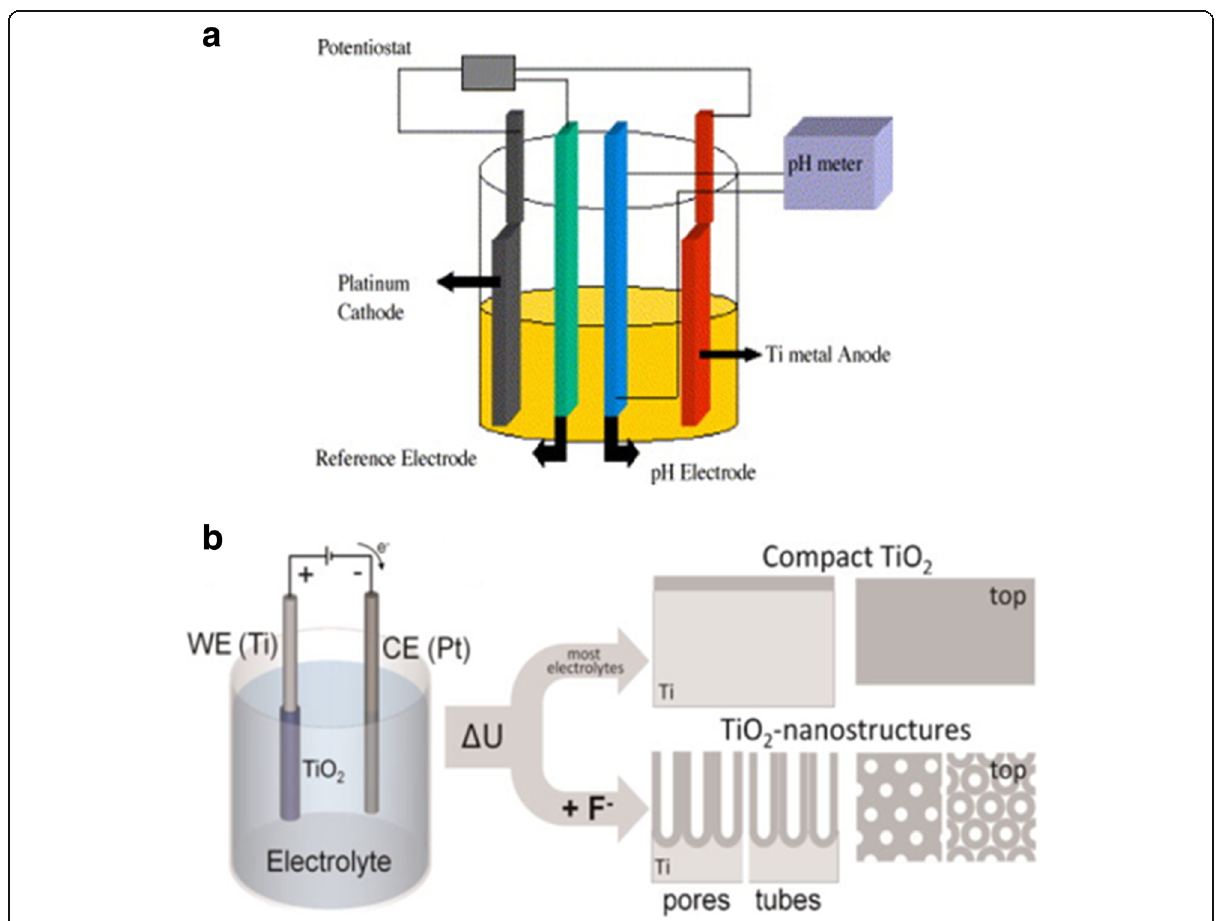
Fig. 2 Schematic set up. a Illustrative drawing of a three-electrode system with the prepared Ti foil as the working electrodes, platinum as the counter electrode, and usually Ag/AgCl as a reference electrode, while the pH electrode as a pH meter. Reproduced from ref. [35]. b Illustrative drawing of a simple two-electrode system composed of Ti foil as anode and inert metal electrode as cathode. Anodization leads to different anodized oxide layer under different conditions. In most neutral and acidic electrolytes, a compact titania can be formed. But if dilute fluoride electrolytes are used, nanotubular/nanoporous oxide layers will be directly attached to the metal surface. Reproduced from ref.